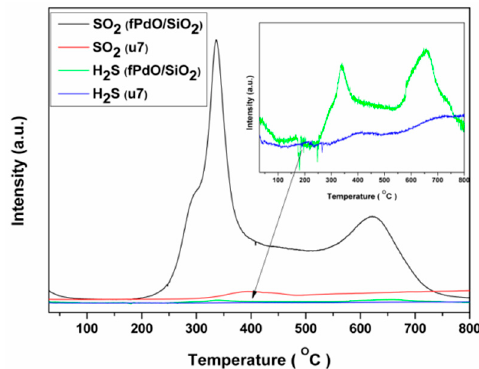
Figure 12. Hydrogen sulfide temperature-programmed desorption (H 2 S-TPD)profiles of the u7 catalyst